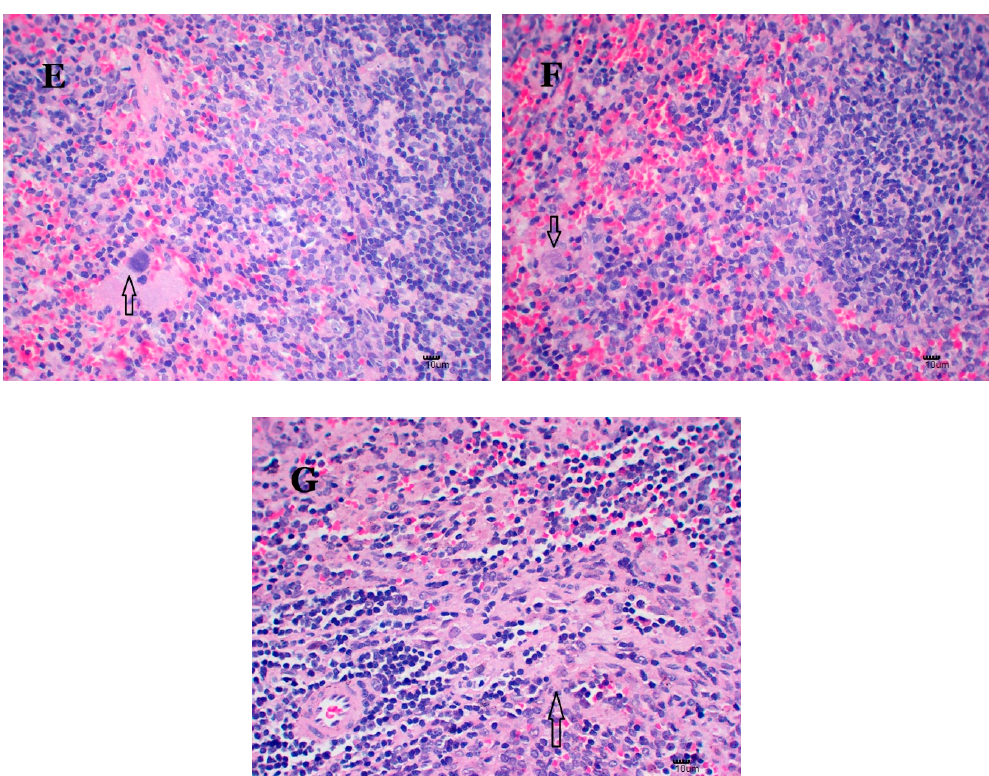
Figure 5. Hematoxylin-eosin staining of splenic sections of rats treated with oral administration of copper-containing preparations for 28 consecutive days. N = 3 per group, scale bar = 10 µ m; 400 × . ( A ) Control group, 1% w / v HPMC solution, or Group I with no histological abnormality; ( B ) micro-Cu group, 200 mg/kg BW, or Group II, without histological abnormality. ( C ) CuCl 2 group, 200 mg/kg BW CuCl2 solution or Group III animals, with increased numbers of macrophages in the red pulp region (arrow); ( D ) degeneration of splenic trabecular artery muscle cells and infiltration of inflammatory cells (arrow); ( E ) nano-Cu low group, 50 mg/kg BW, or Group IV, with increased numbers of macrophages (arrow); ( F ) nano-Cu medium group, 100 mg/kg BW, or Group V, with increased numbers of macrophages (arrow); ( G ) nano-Cu high group, 200 mg/kg BW, or Group VI, with amyloid degeneration (arrow).